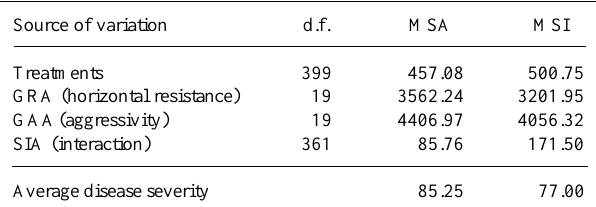
Table VI - Diallelic analysis of disease severity showing mean square according to additive model (MSA) and interactive model (MSI) including 20 hosts and 20